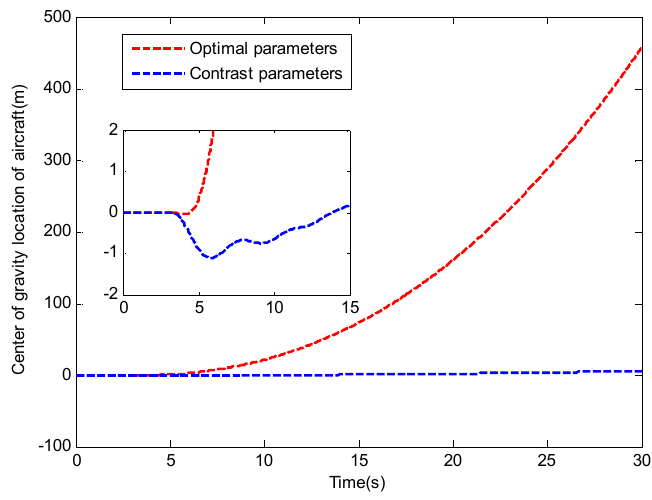
Figure 8. Center of gravity location of aircraft.